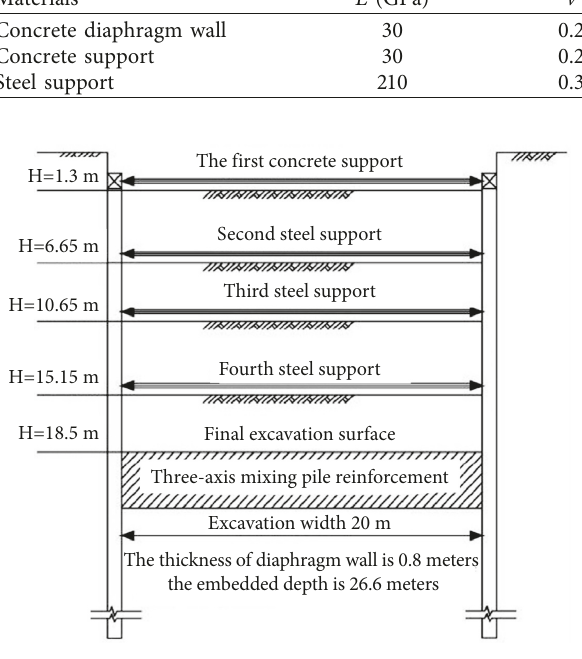
Figure 2: Sectional view of the foundation pit’s support structure in a standard